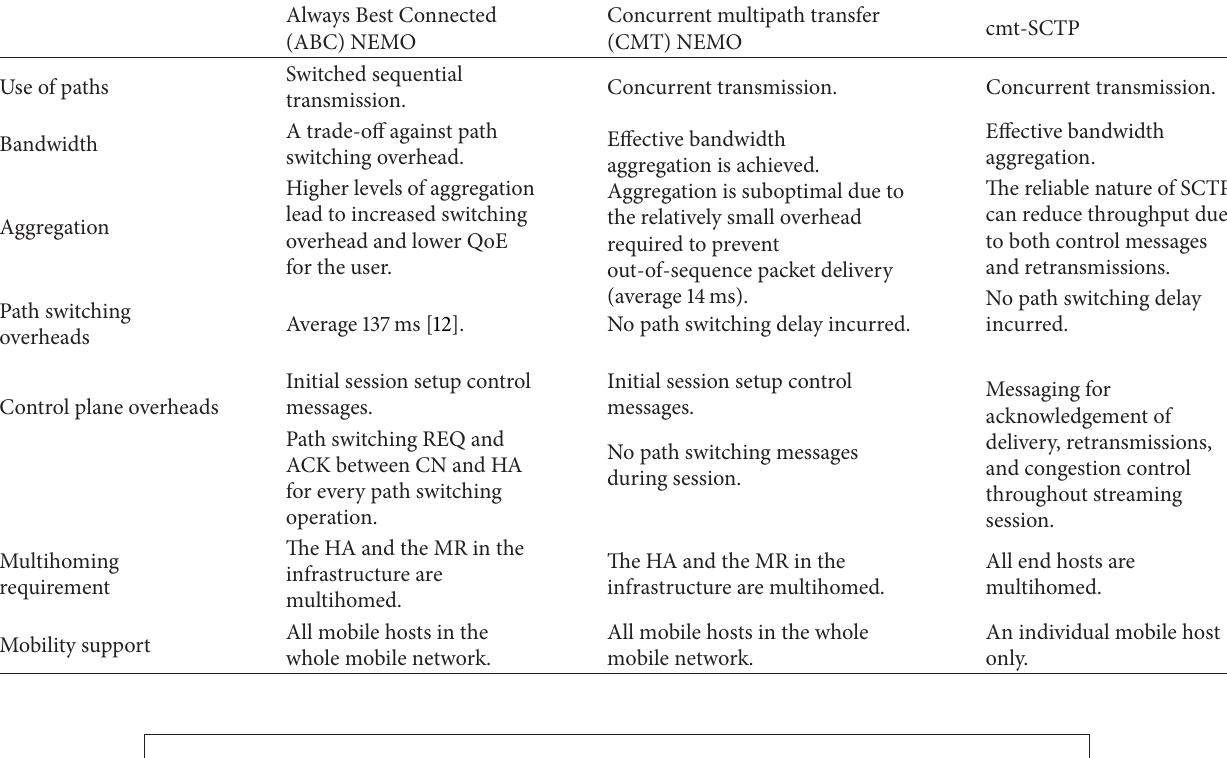
Table 1: Features of the three schemes.